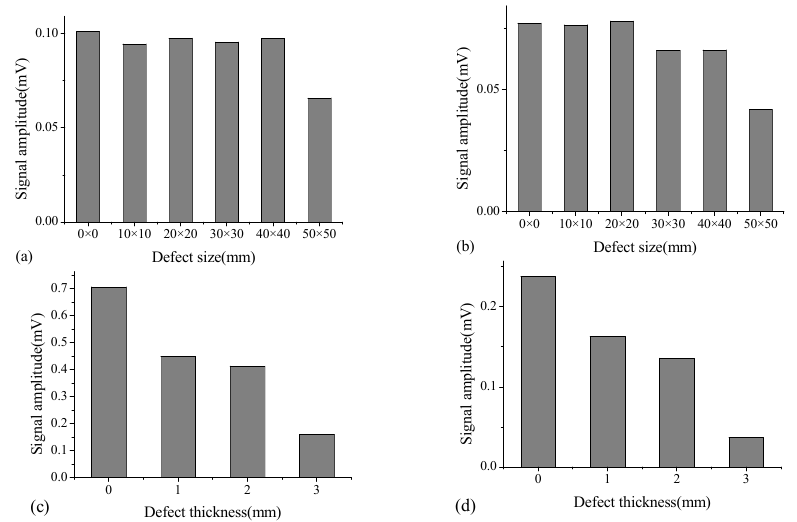
Figure 12. Output voltage amplitude for A ‐ type specimen with different defect sizes under excitation voltage frequency of ( a ) 10 kHz; ( b ) 15 kHz, and those for B ‐ type specimen with different defect thicknesses under excitation voltage frequency of ( c ) 10 kHz; and ( d ) 15 kHz.